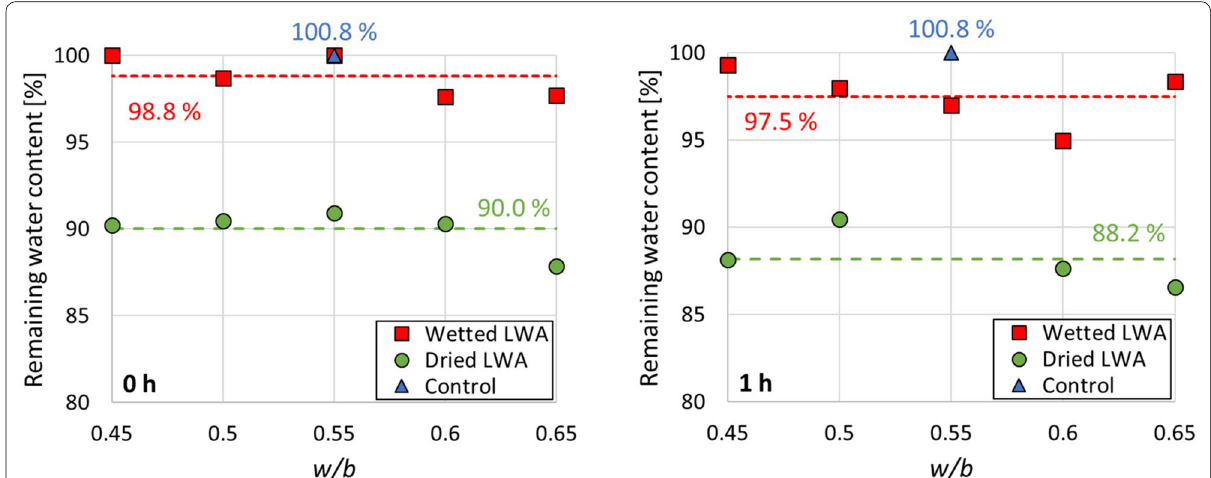
Fig. 6 Remaining water content in concrete